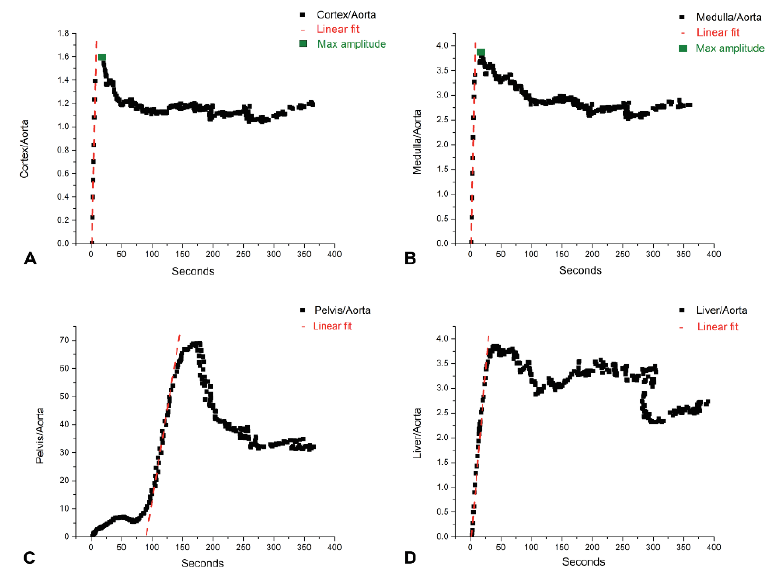
Figure 9. Plotted Patlak graphical analysis data, with examples represented for kidney cortex ( A ), medulla ( B ), pelvis ( C ), and liver ( D ), with superimposed linear fit for the analyzed duration and the maximum amplitude points.